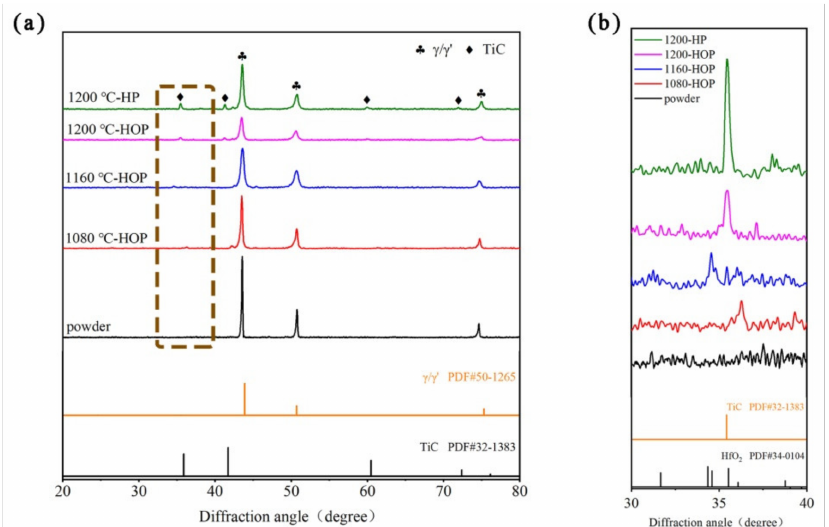
Figure 4. X-ray diffraction (XRD) analysis of the samples with various processes: ( a ) overall profile; ( b ) the enlarged profile of the dashed box in Figure 4a.